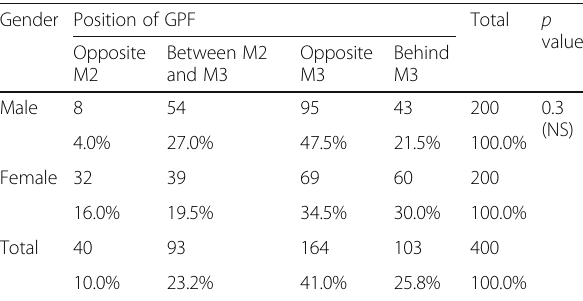
Table 2 Frequency and percent of position of the GPF based on